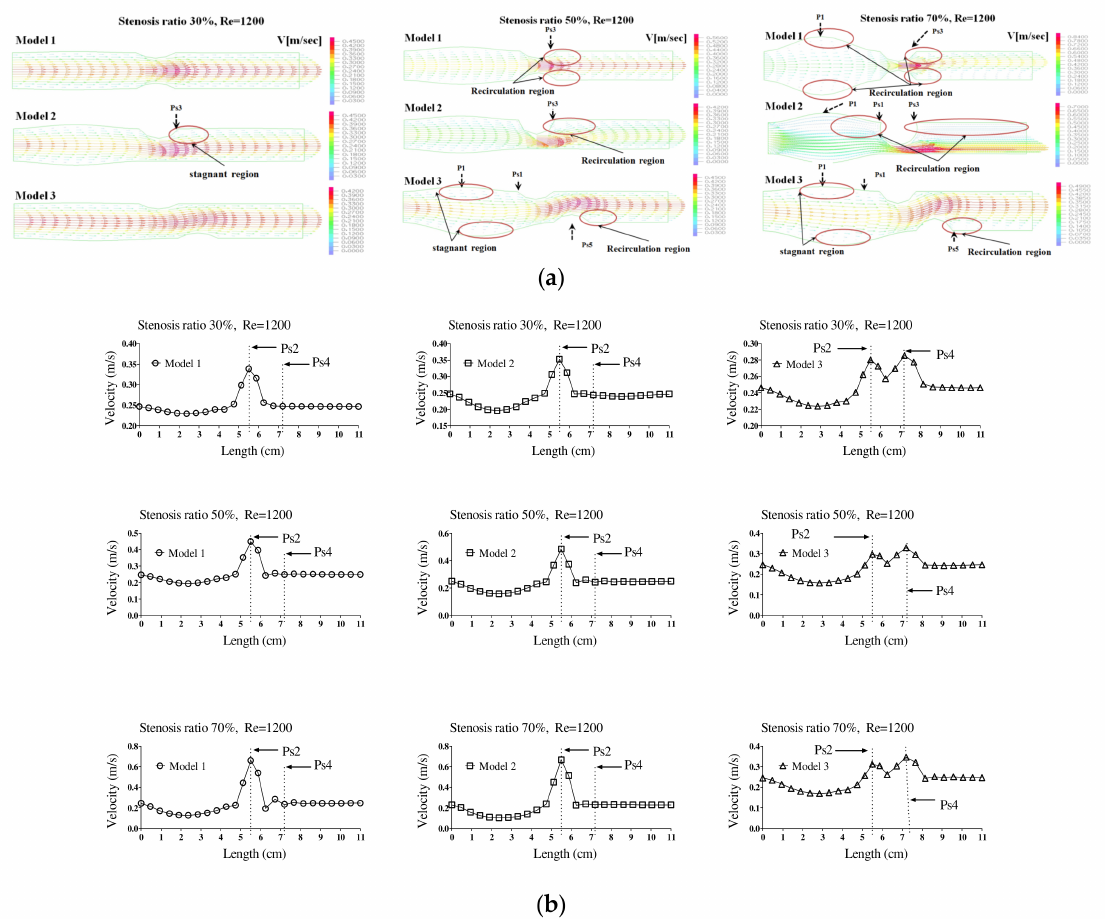
Figure 1. The velocity distribution and average velocity in the continuous flow field based on changes to the stenosis ratio at each point of the modules. ( a ) Velocity distribution, ( b ) average velocity. Figure 2a,b show the velocity distribution and average velocity in the pulsatile flow field based on changes to the stenosis ratio at each point of the modules. The vortex was partially formed as the stenosis rate increased during diastole, and then the recirculation region and stagnant layer were formed. Especially when the stenosis rate was 70%, the velocity distribution was very complex and a biased flow was shown. The location for the recirculation region and stagnant layer was shown variously based on the shape of the stenosis. When the stenosis rate was 70%, the velocity distribution was biased on one